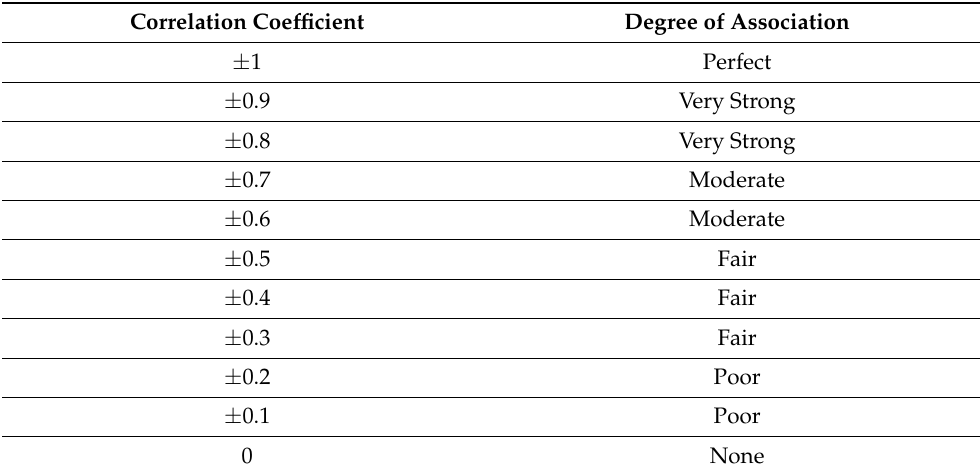
Table 1. The Spearman’s rank correlation coefficient ranges from -1 to 1 indicating various degrees of association between radiomics